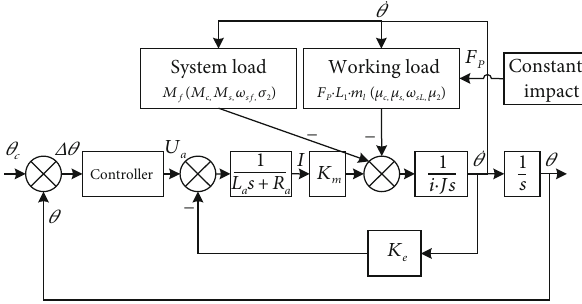
Figure 11: Simulation model of the fl ow